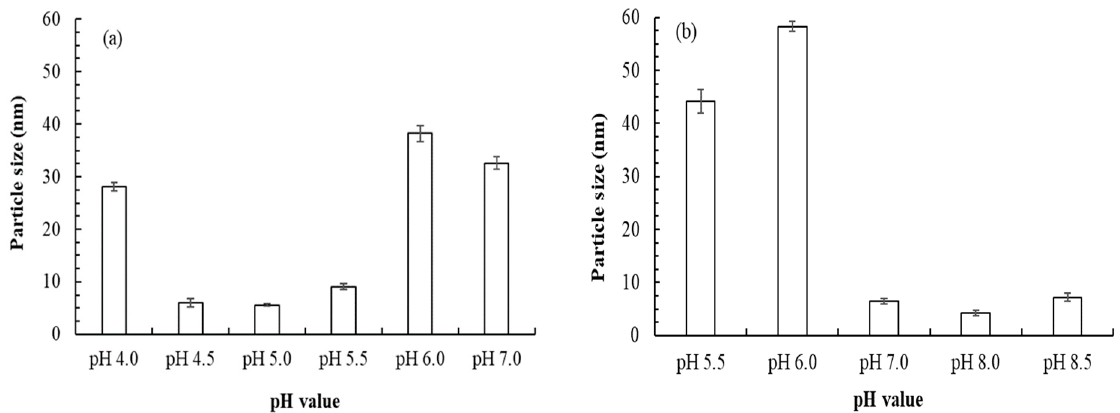
Figure 2. Effect of pH on the particle size of AuNPs synthesized by ( a ) B. lactis after 72 h of incubation and ( b ) E. coli after 24 h of incubation.